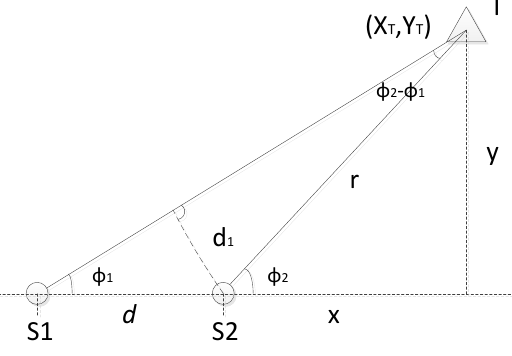
Figure 1. Schematic of lateral cross positioning.